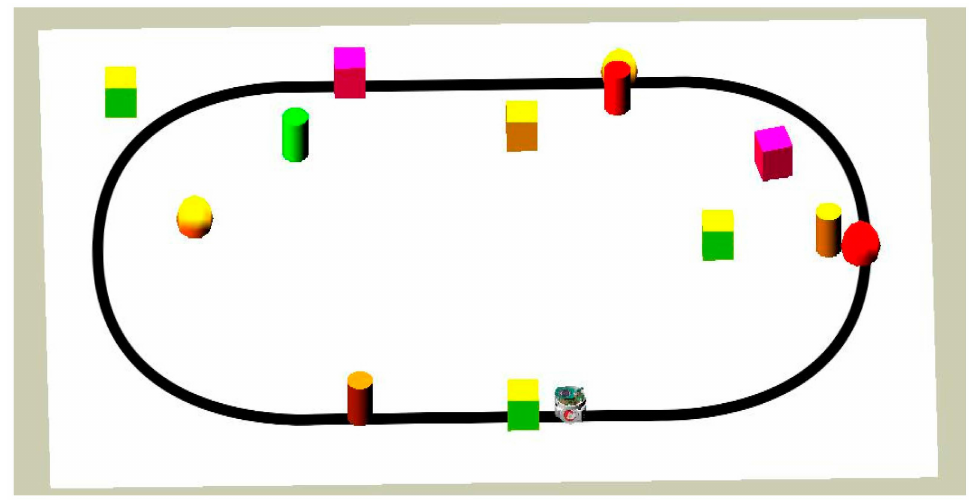
Figure 17. Simulation overview of the mobile robot and the environment.